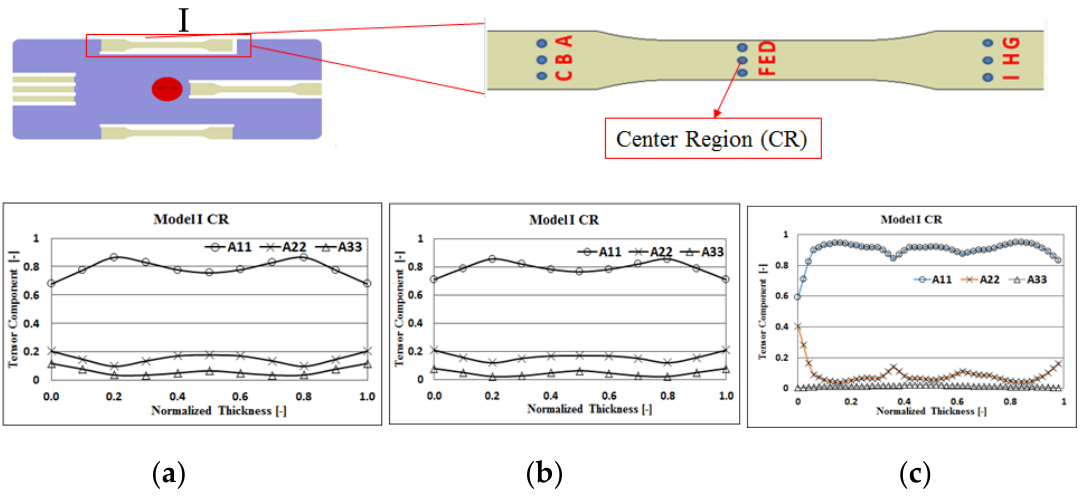
Figure 8. The comparison of the fiber orientation tensor components for Model I at Point E at CR: ( a ) simulation without flow–fiber coupling, ( b ) simulation with flow–fiber coupling, ( c ) experimental observation.